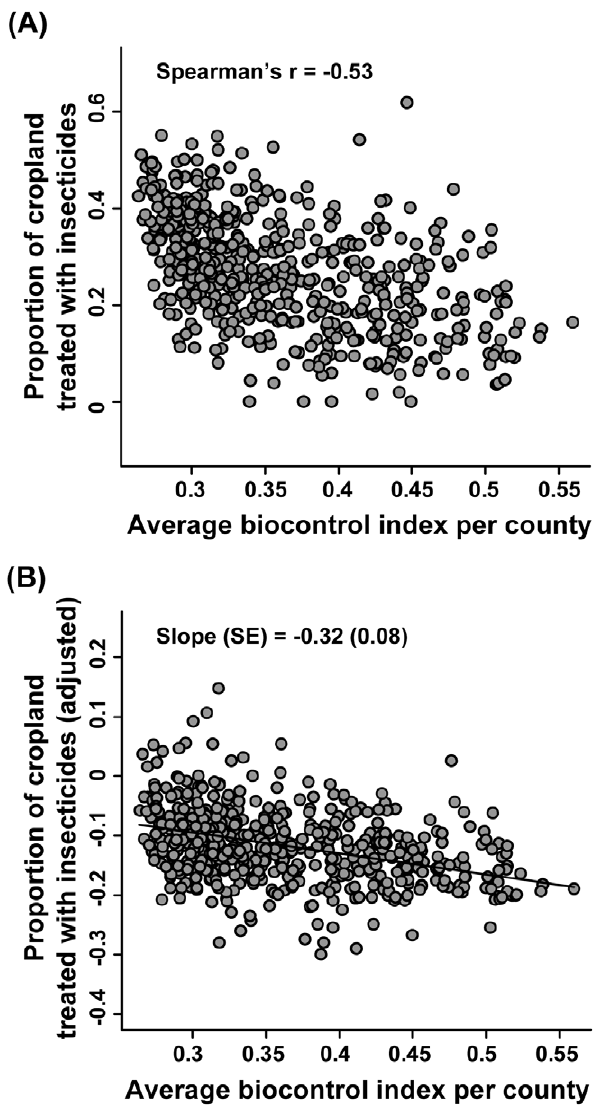
Figure 5. Biocontrol index and insecticide use. (A) Negative relationship between the empirical biocontrol index, averaged across pixels in a county, and relative insecticide use, expressed as the proportion of cropland in a county that is treated with insecticides. Data are for 562 counties in seven states of the Midwestern United States, including Wisconsin, Michigan and neighboring states (medium gray polygons in Figure 1A). (B) Insecticide use has been adjusted to account for other associated factors, such as the proportion of cropland in corn, soybean and small grains, and fruits and vegetables, producer net income per ha, and unspecified spatially-structured factors.